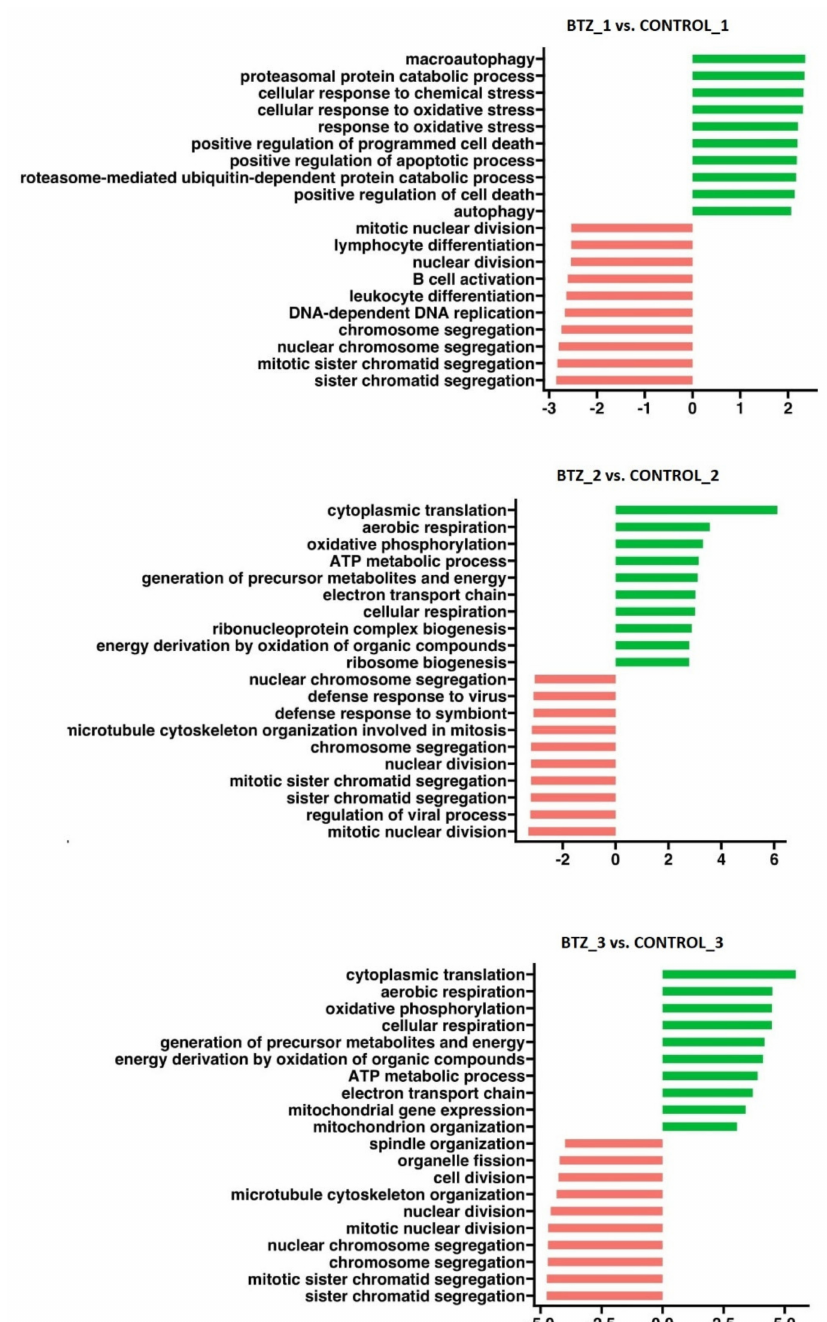
Figure 8. GSEA performed in U266 cells after BTZ administration (BTZ_1—first treatment; BTZ_2—second treatment; BTZ_3—third treatment). The plots show the normalized enrichment scores (NES) for the most positively and negatively enriched gene sets. The green color shows activation of selected processes, and the red color shows inhibition. p <